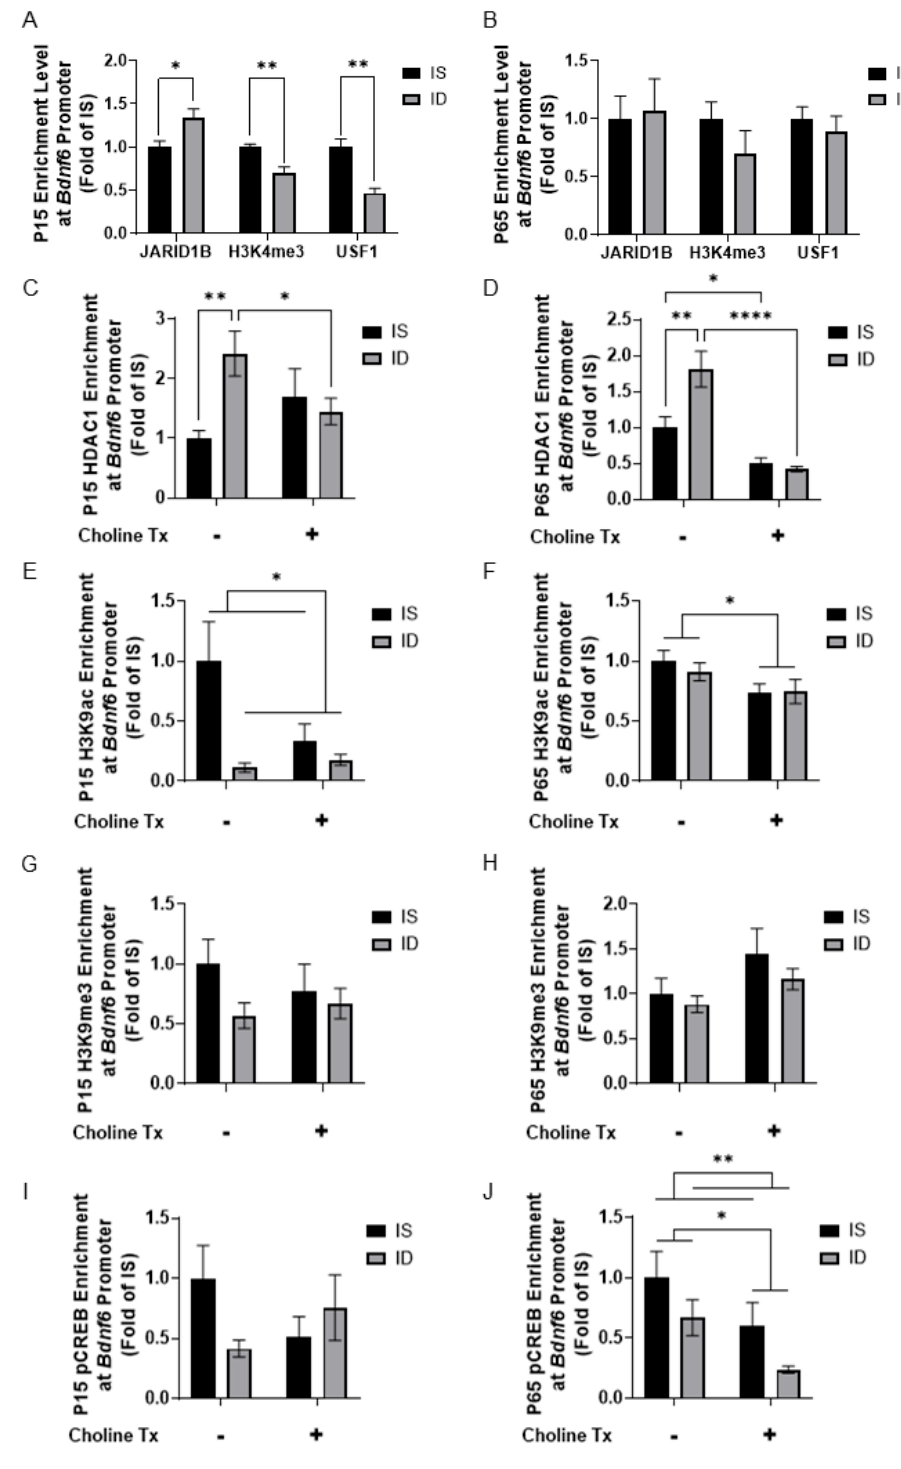
Figure 6. Iron deficiency and choline supplementation induce epigenetic changes at the hippocampal Bdnf6 promoter. ( A , B ) Enrichment levels of JARID1B, H3K4me3 and USF1 at the Bdnf6 promoter in P15 ( A ) and P65 ( B ) IS and ID groups. ( C , D ) HDAC1 enrichment at the Bdnf6 promoter in the 4 groups at P15 ( C ) and P65 ( D ). ( E , F ) H3K9ac enrichment at the Bdnf6 promoter in the 4 groups at P15 ( E ) and P65 ( F ). ( G , H ) H3K9me3 enrichment at the Bdnf6 promoter in the 4 groups at P15 ( G ) and P65 ( H ). ( I , J ) pCREB enrichment at the Bdnf6 promoter in the 4 groups at P15 ( I ) and P65 ( J ). All data were assessed by qChIP and normalized to the age-matched IS group. Tx: Treatment (Supplementation). Values are mean ± SEM; n = 5–6/group; * p < 0.05, ** p < 0.01, **** p <